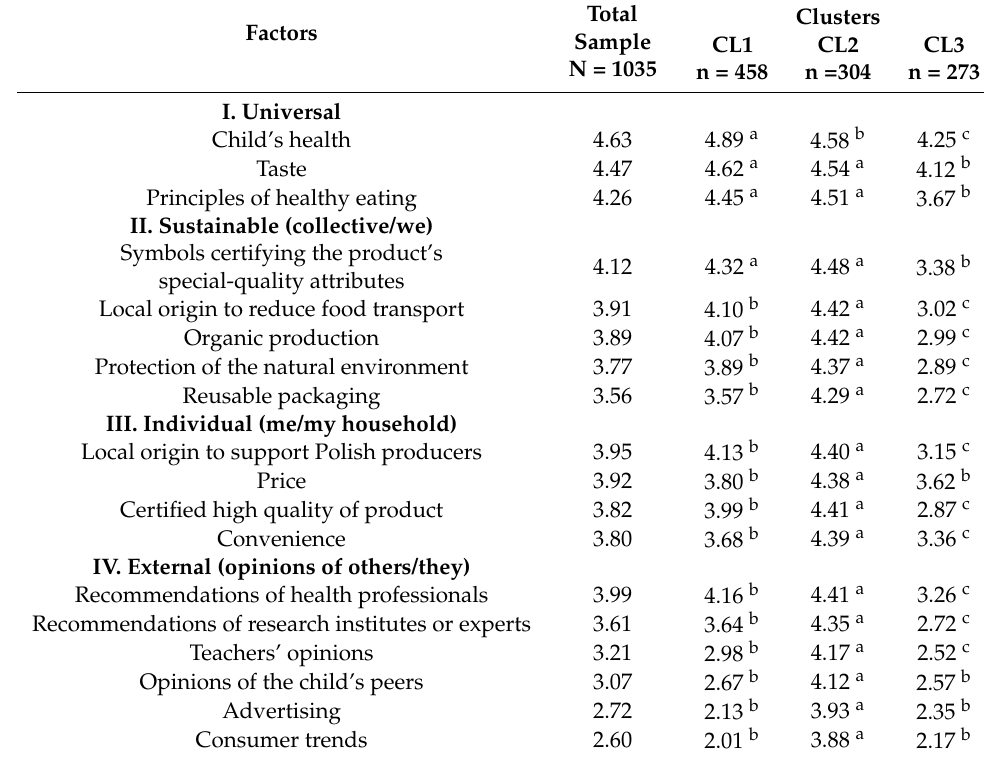
Table 2. Post-hoc analysis of the total sample and cluster means for factors determining parental food